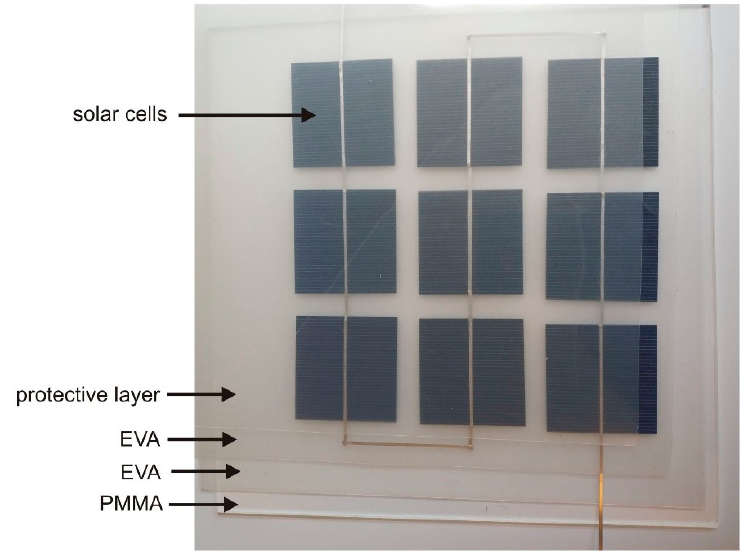
Figure 6. Layout of material layers in the mini PV module.